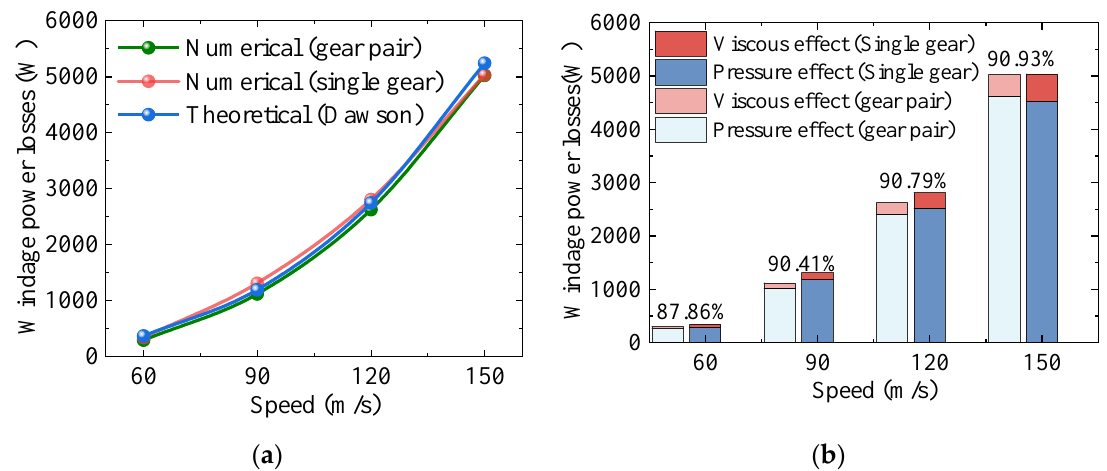
Figure 5. WPL: ( a ) Comparison of numerical results and theoretical results obtained by the formula of Dawson; ( b ) Proportion of the pressure and the viscous effect.